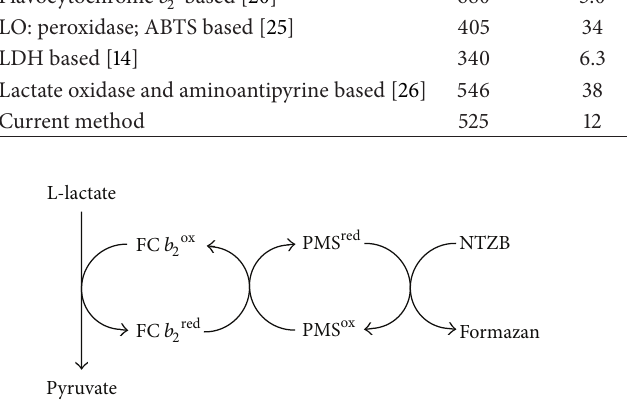
Figure 1: The scheme of the reactions exploited in enzymatic assay of